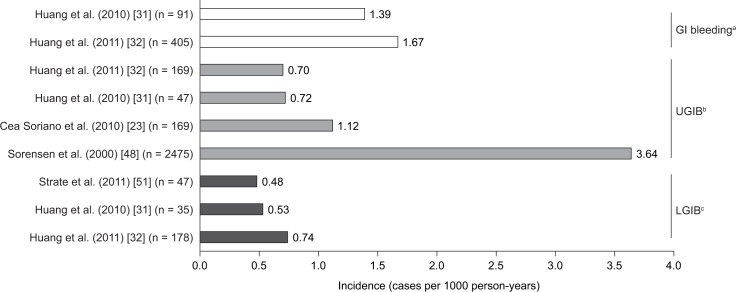
Incidence (cases per 1000 person-years) of gastrointestinal bleeding with low-dose aspirin.aIncidences for all GI bleeding as reported in the original studies, without specification of location within the tract; bincidences specifically for upper GI bleeding as reported in the original studies; cincidences specifically for lower GI bleeding as reported in the original studies. GI, gastrointestinal; LGIB, lower gastrointestinal bleeding; UGIB, upper gastrointestinal bleeding.